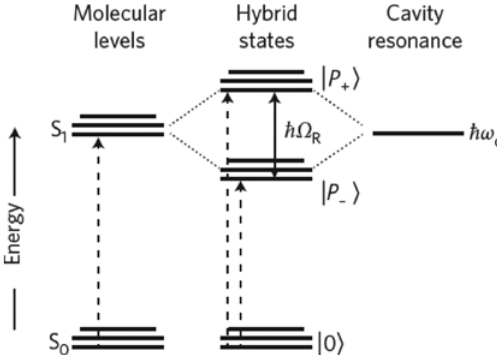
Figure 5: Simplified energy landscape shows that there is an energy exchange between the transition (HOMO-LUMO) of mole- cules and the cavity, which is rapid compared to energy loss. Two hybrid states +〉 −〉 (| and | ) P P are formed due to strong cou- pling. Note that the coupled system ground-level energy 〉 |0 may be modified by strong coupling